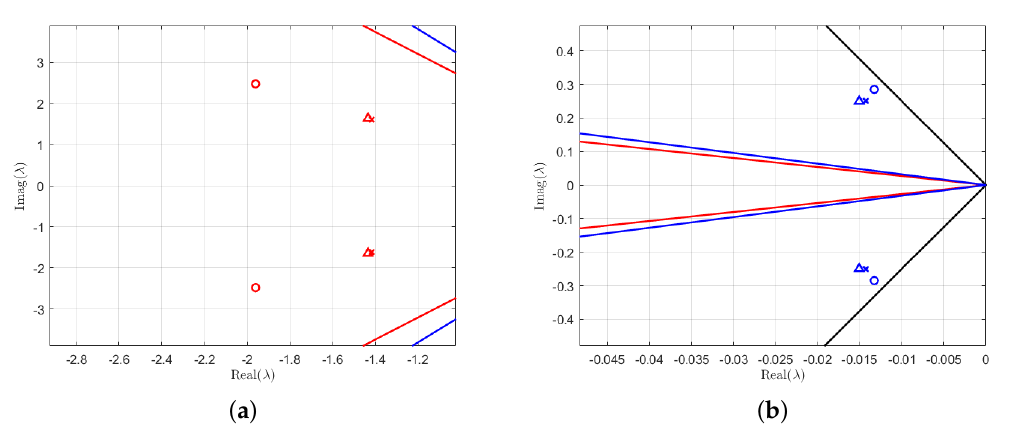
Figure 7. Eigenvalues of short period ( a ) and phugoid ( b ) for the two-surface testbed (triangles), three-surface testbed (circles) and three-surface with re-assigned dynamics via Scheme A (crosses). Lines represent limits for Level 1 flying qualities (black lines: phugoid, blue lines: Category B short period, red lines: Category A short